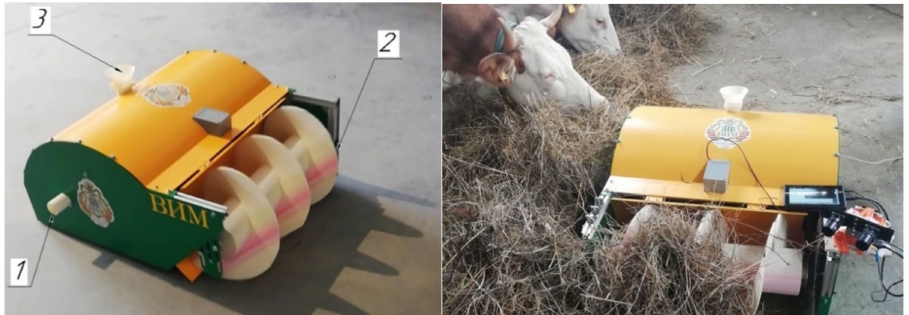
Figure 12. Physical analogue of a robot pusher; 1, outlet of the feed additives dispenser; 2, pusher auger; 3, filler with a closer.